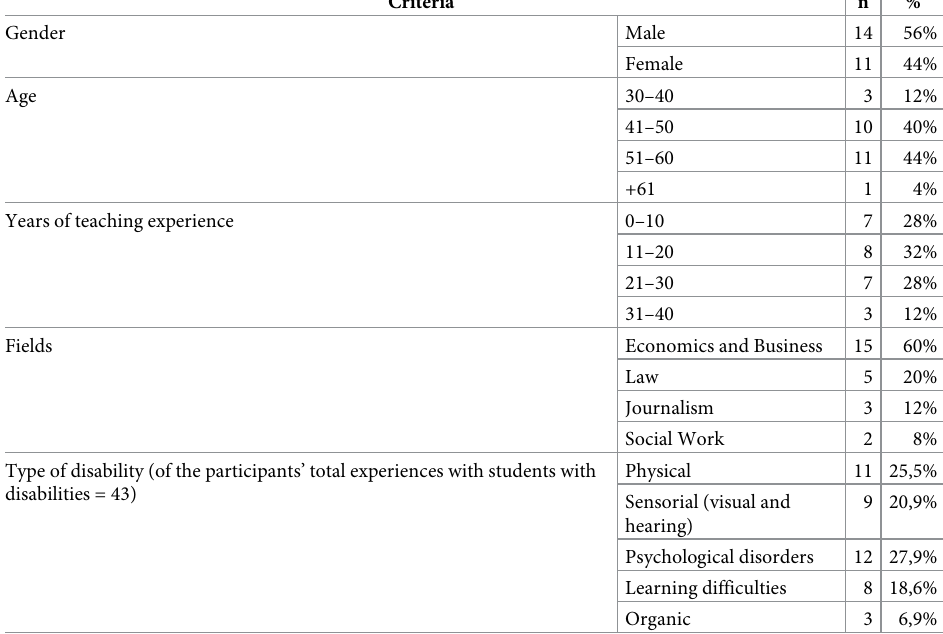
Table 1. Participant’s